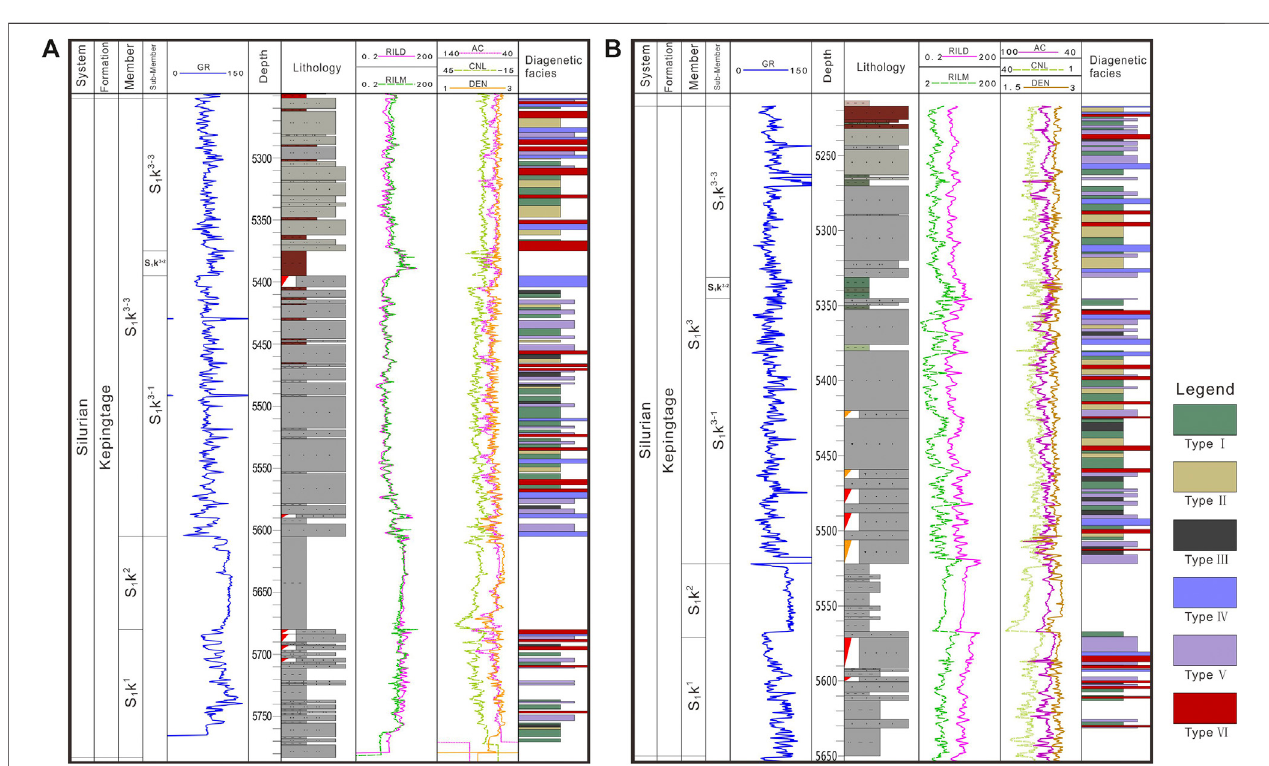
FIGURE 7 | The identi fi cation result of diagenetic facies of Kepingtage Formation (A. Well SH903H. B . Well SH10.) (The fi rst fi fth tracks display system, formation, member, sub-member, and gamma curve respectively. Depth and lithology are shown in the sixth and seventh track. The eighth and ninth tracks display the key logs involved in diagenetic facies calculation. The last track exhibits the results of the diagenetic facies identi fi cation.).